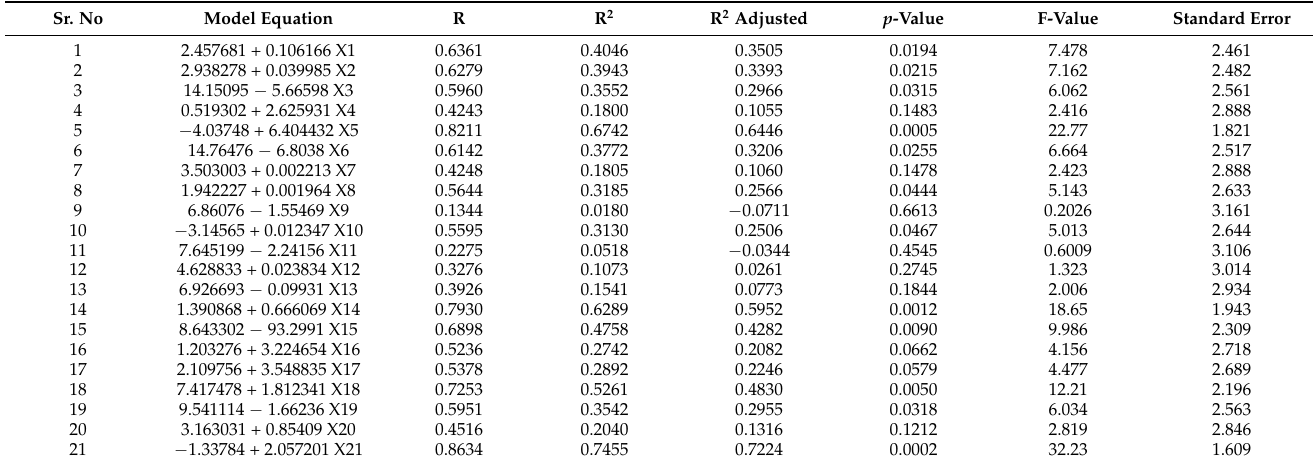
Table 4. Linear regression analysis to show the relationship between the adsorption capacity (K F ) of Aerva javanica obtained from the Freundlich isotherm and metal ionic